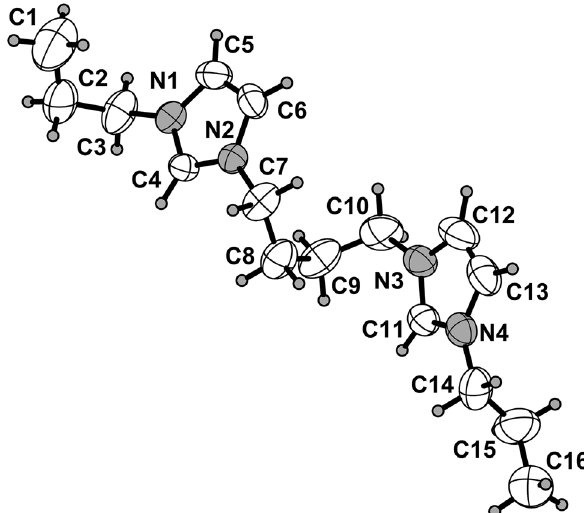
Table  : Data collection and